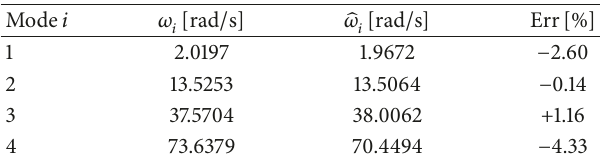
Table 16: Modal parameters estimated on the undamaged continu- ous bending moment-deflecting structure by using the RWS-TSVD- based algorithm.